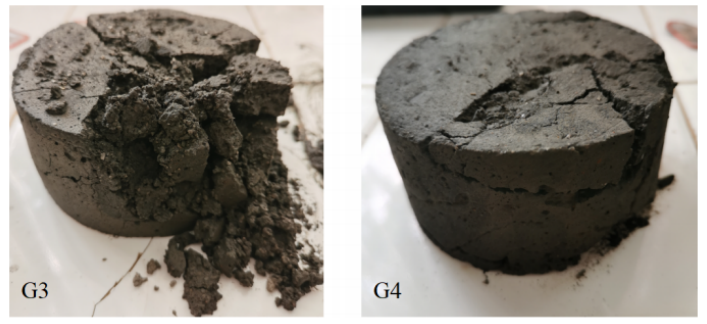
Figure 11. Failure modes of G3 and G4 specimens after water